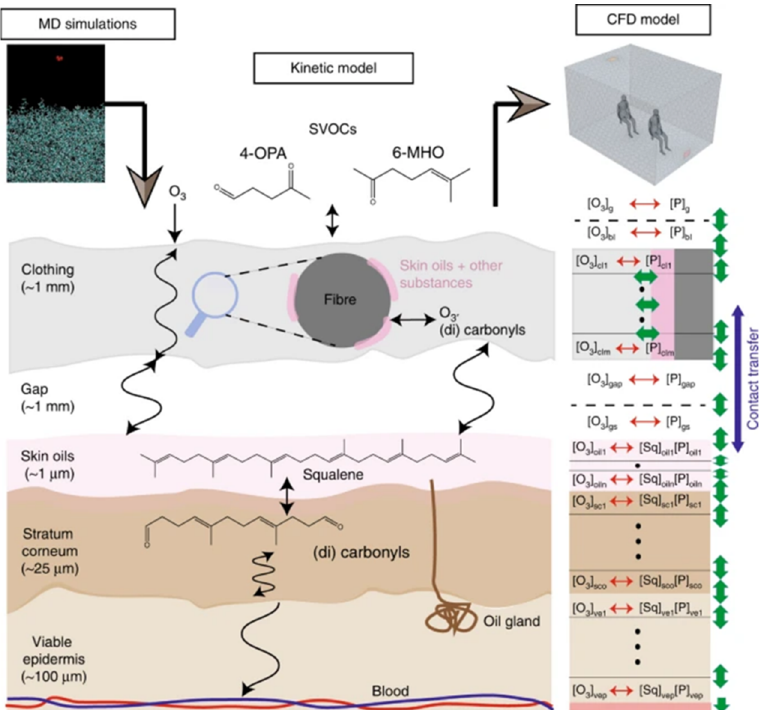
Figure 5. Schematic representation of the kinetic multilayer model developed in [48] for skin–cloth– ozone interactions. Figure reproduced from [48] under the terms and conditions of a Creative Commons license agreement.